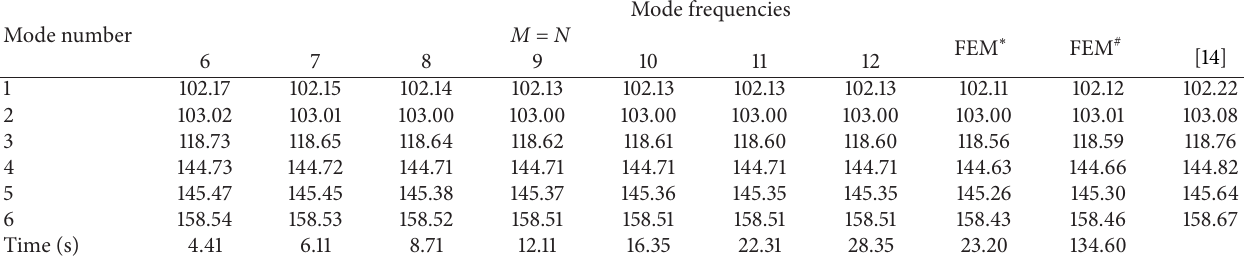
Table 1: Frequency parameters for a completely clamped doubly curved shallow